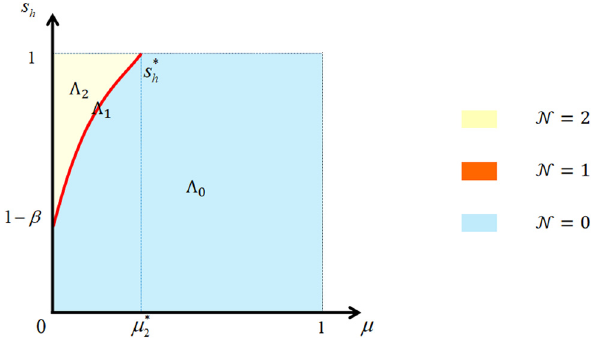
Figure 1: The division of parameter space Λ